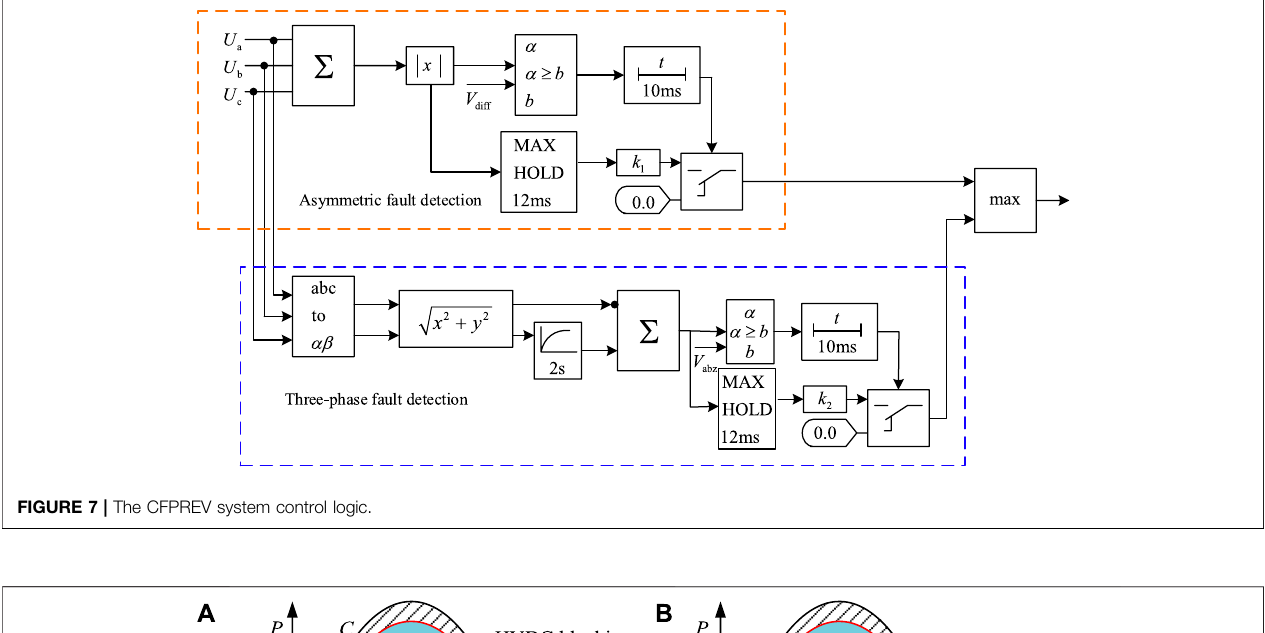
FIGURE 7 | The CFPREV system control logic.